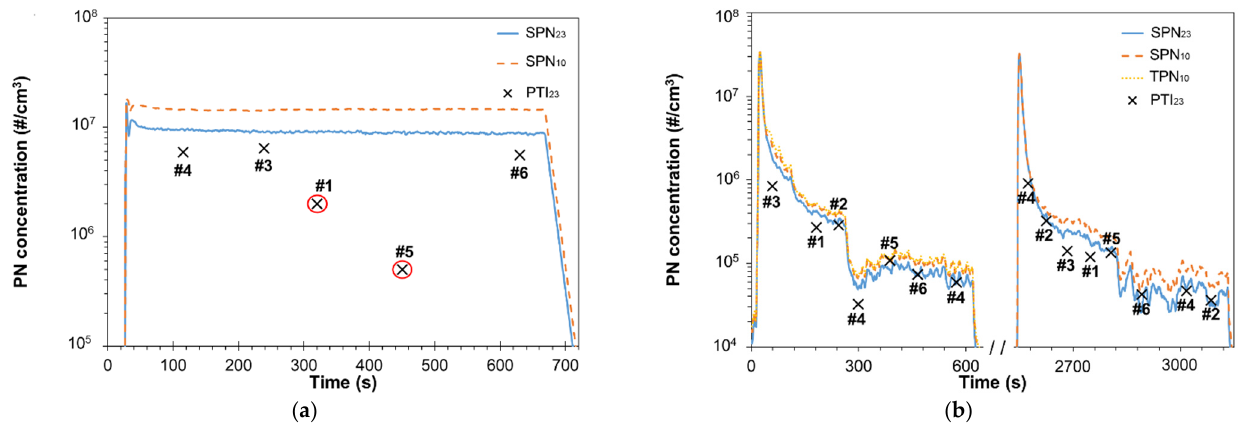
Figure 2. Particle number concentrations during low idling with cold start engine of direct injection vehicles without particulate filter: ( a ) diesel V6; ( b ) gasoline V5. Points in red circle show that the PTI sensors reported a threshold concentration that corresponds in automatic failure (2 × 10 6 #/cm 3 for NL or 5 × 10 5 #/cm 3 for DE).